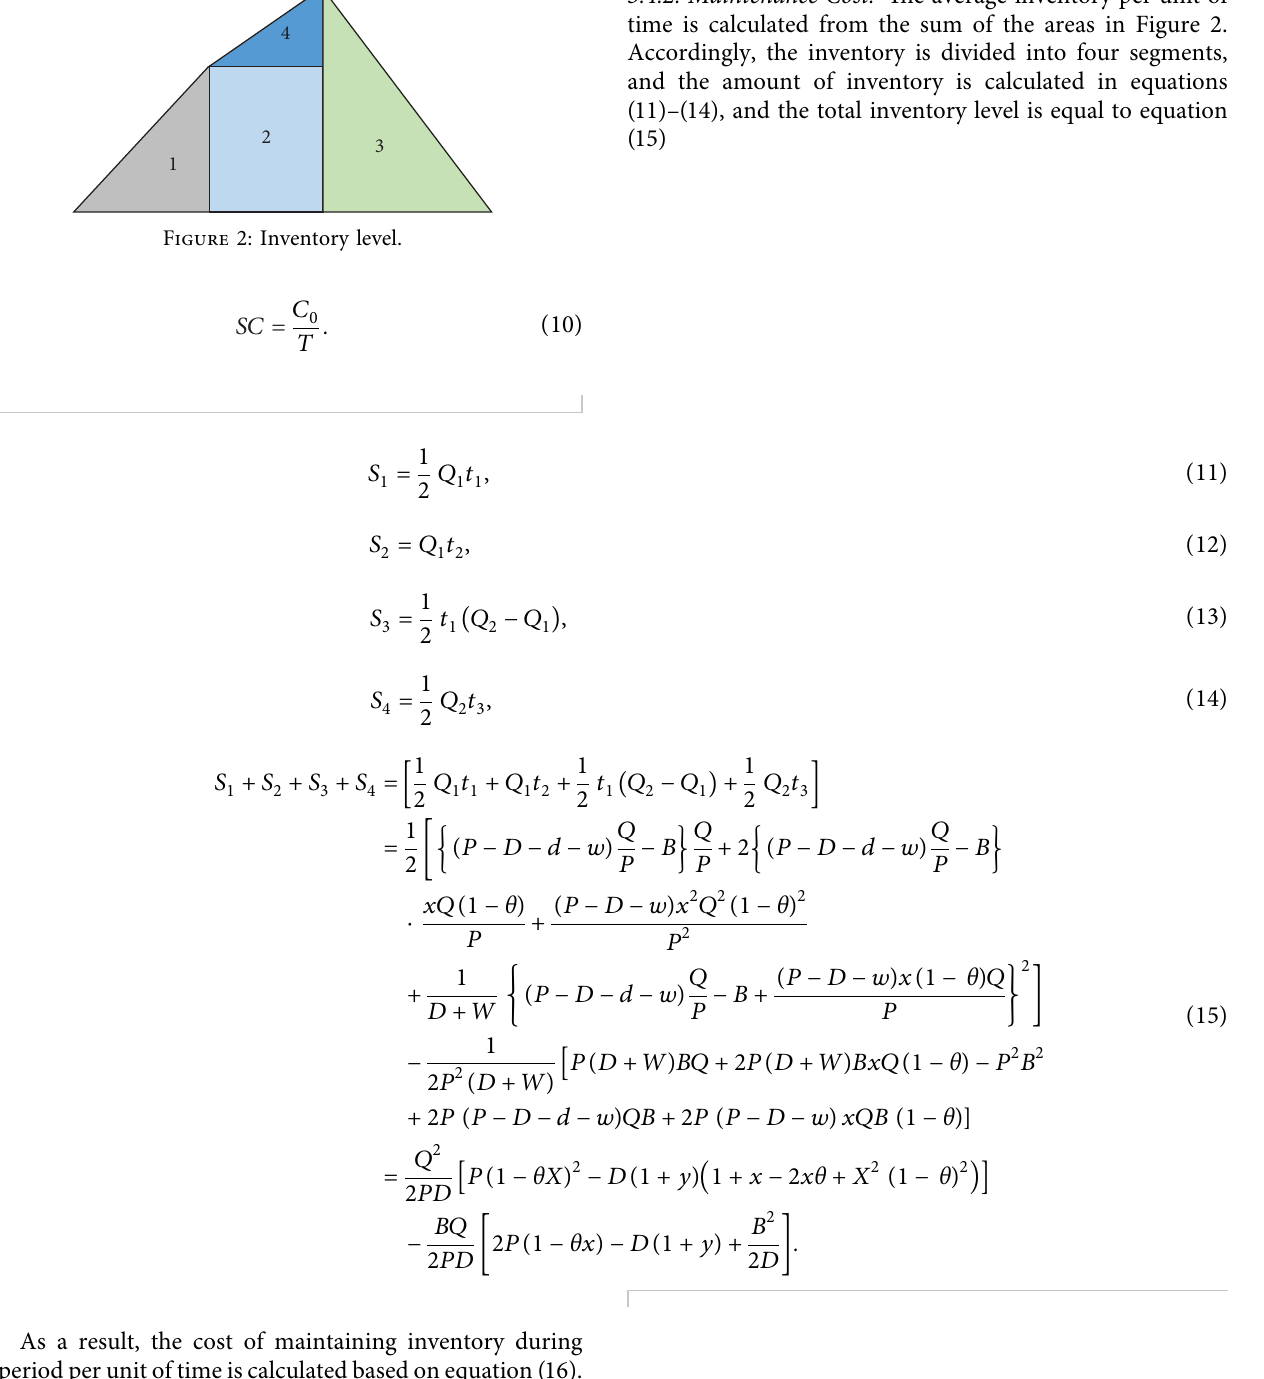
Figure 2: Inventory